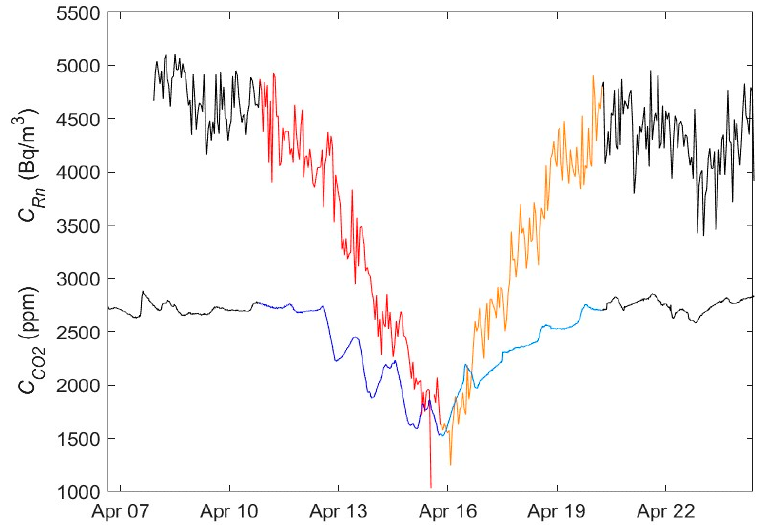
Figure 5. Variation in the gas concentration of event 1 in April 2015, which is shown in Figure 4. The radon degassing is shown (in red), the recharging (orange) and the CO 2 degassing (dark blue) and the recharging (light blue).